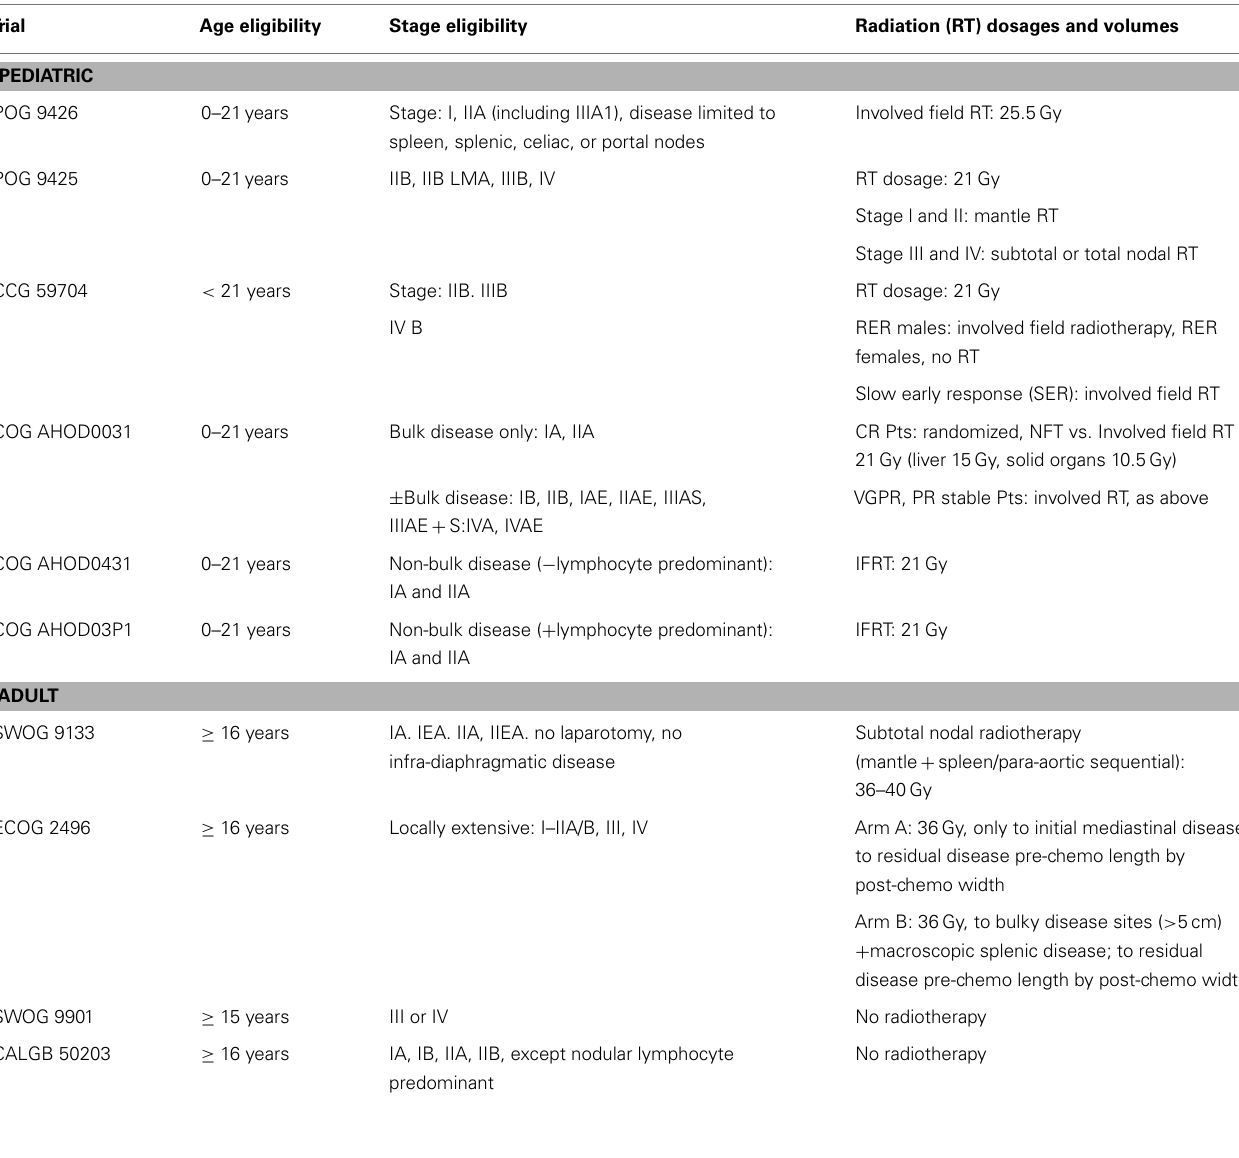
Table 2 | Selected protocol eligibility criteria and details of protocol specified RT